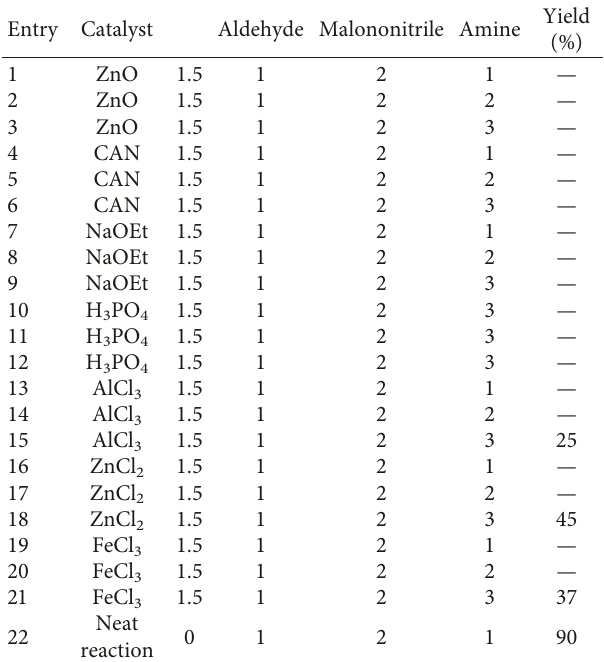
Table 1: Optimization of reaction